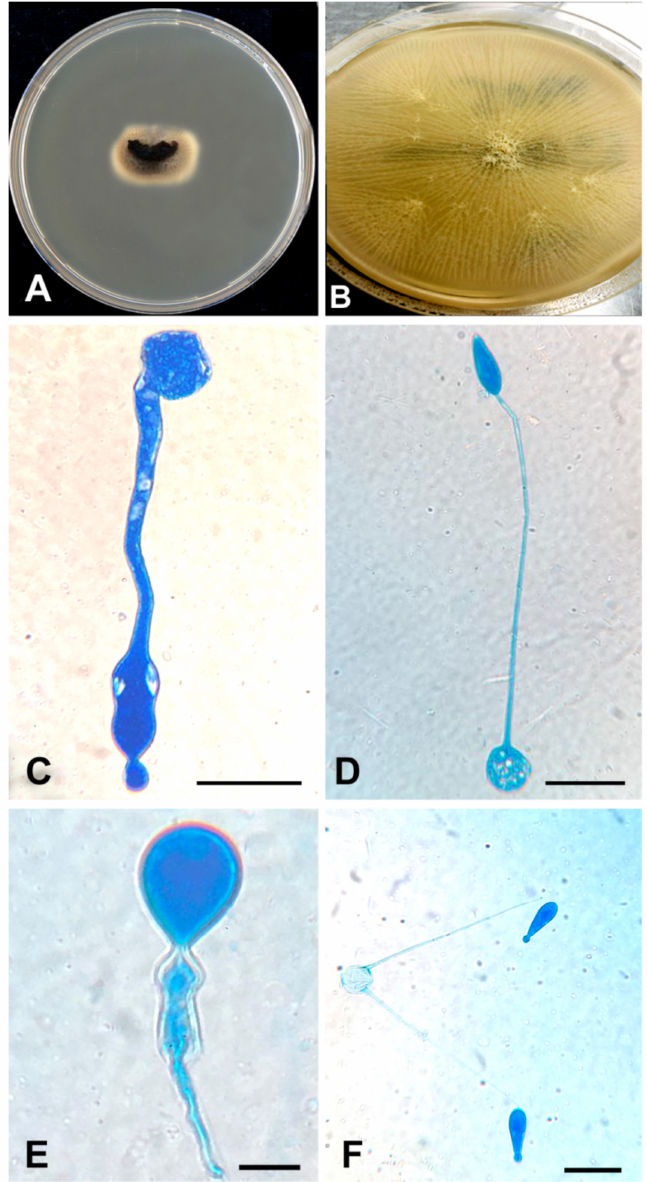
Figure 2. ( A ) Direct culture (SAB) from the thrombus. A piece of the thrombus (the black material at the centre) was put on a SAB plate. After incubation, the mould grew from it. ( B ) Colonial appearance of flat, radially folded, waxy, yellow-cream colonies on SAB. ( C – E ) Wide hyphae and club-shaped spores with knob-like tips demonstrated with lactophenol cotton blue stain. ( F ) The thin ballistoconidia in the primary culture. All scale 10 µ